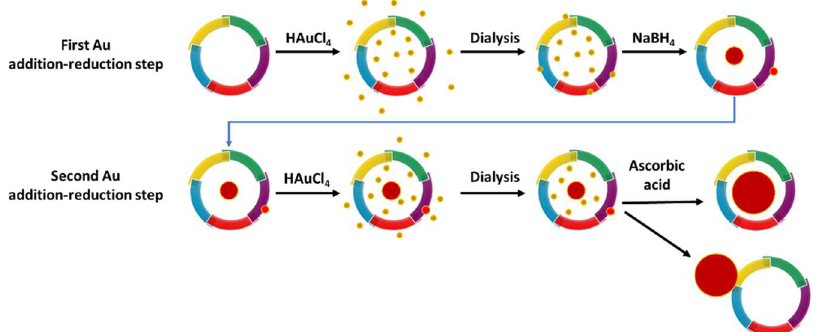
Figure 1. Diagram of the 2-step gold nanoparticle synthesis protocol in recombinant human ferritin. It cannot be discarded that some gold atoms could be on the outer ferritin surface after the first dialysis, giving rise to nanoparticles outside the formation.